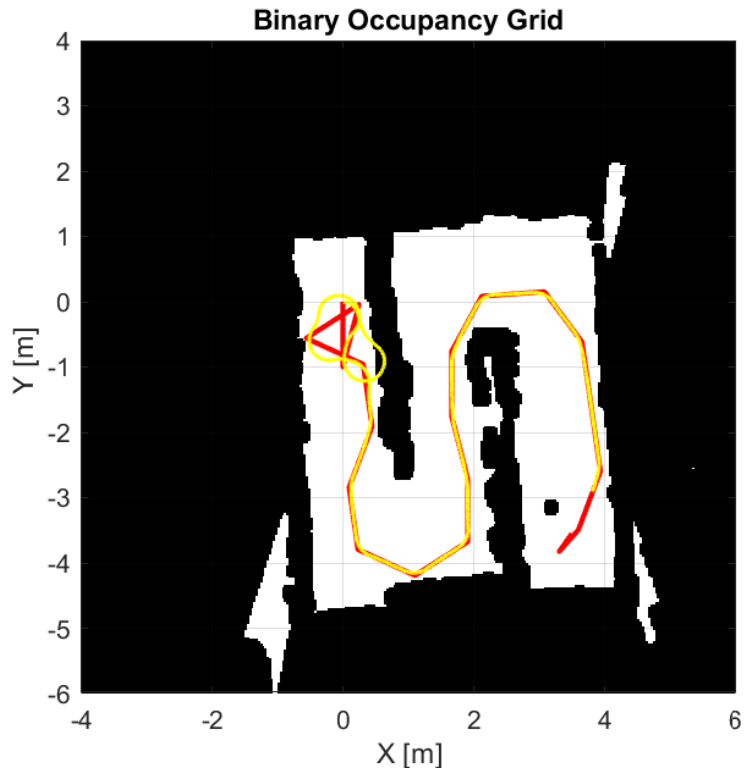
Figure 33. Desired waypoints obtained with HybridA star algorithm and path obtained from odome- try data.